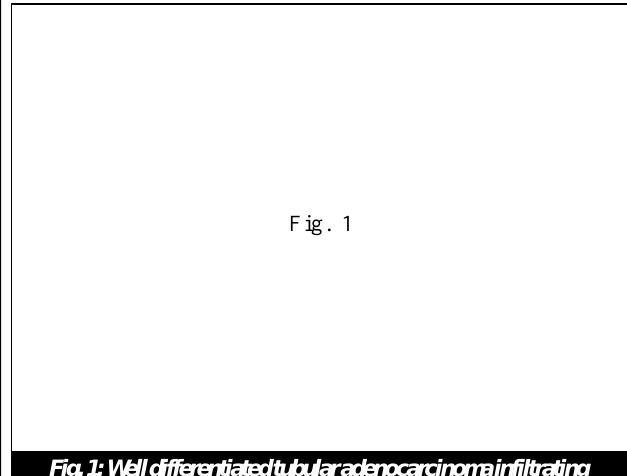
Fig. 1: Well differentiated tubular adenocarcinoma infiltrating into the muscular layer of the colon (HE X 40)